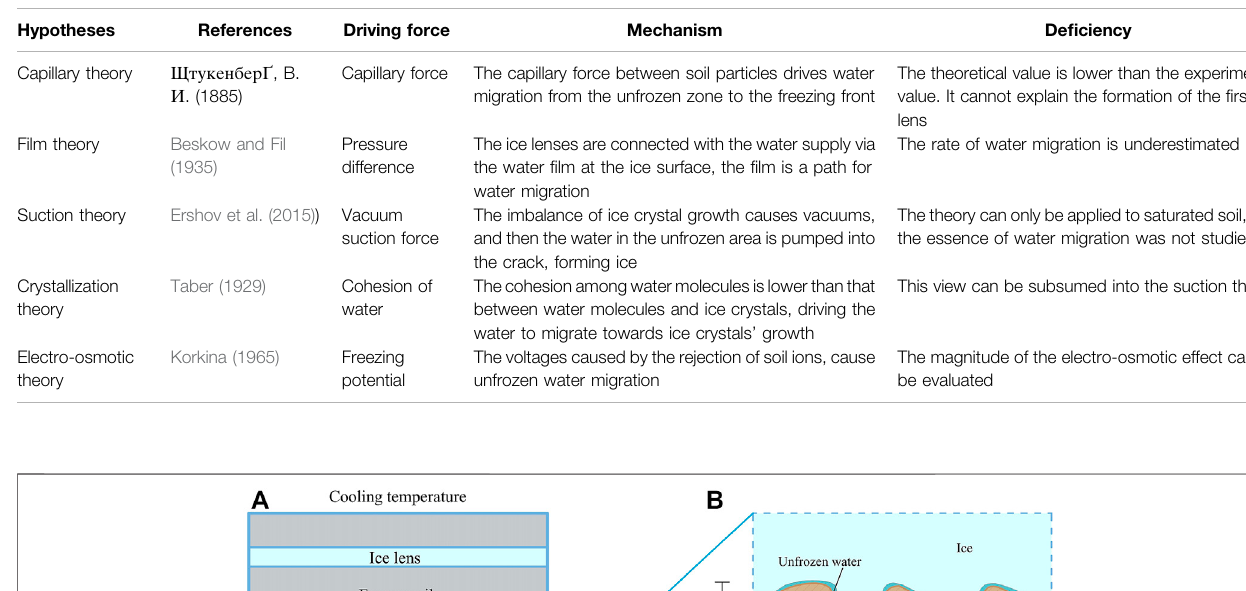
TABLE 1 | Hypotheses on the driving force of water migration in frozen soil.